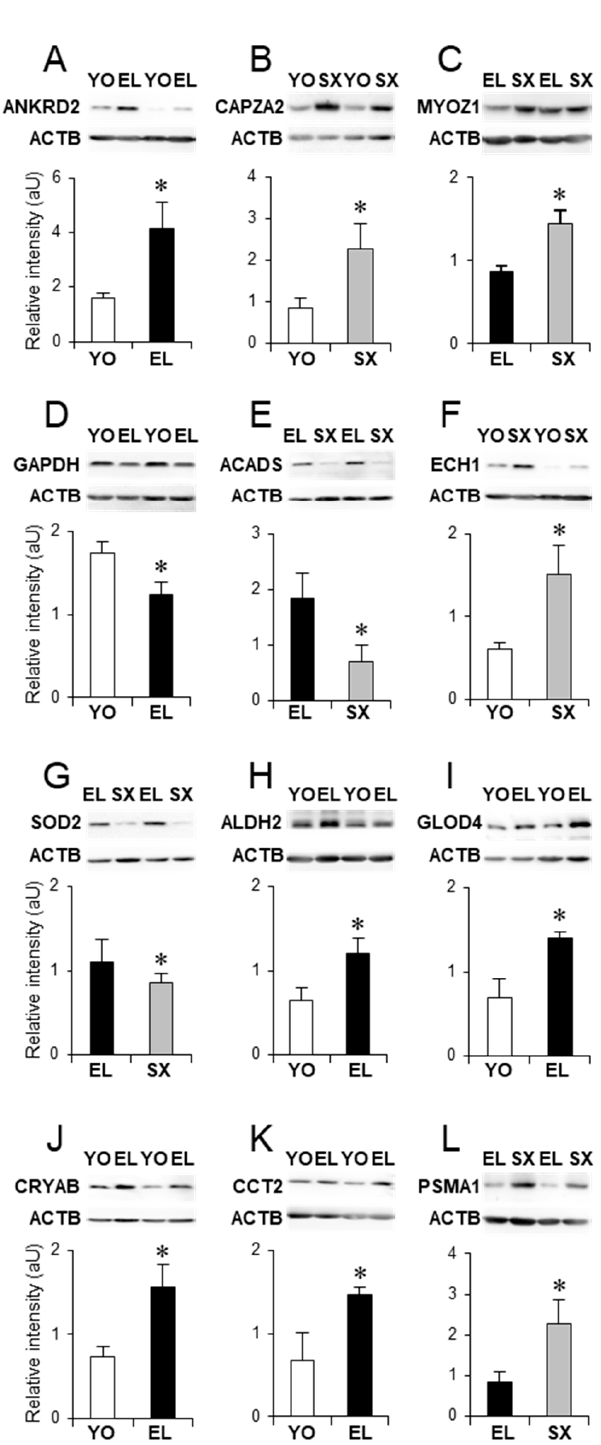
Figure 5. Proteins differentially expressed with healthy aging and metabolic syndrome in old men. Examples of differential expression of proteins associated with myofibrillar filaments ( A – C ), energy metabolism ( D – F ), cytoprotection and cytodetoxification ( G – K ), and proteolysis ( L ). In each panel, a representative Western blot is shown, and the histogram represents Western blot quantification ( n = 7) for young (YO), healthy old men (EL), and old men with metabolic syndrome (SX). The protein names are listed in Table 2. Results are shown as means ± SE. * p < 0.05 indicates significant difference between groups.